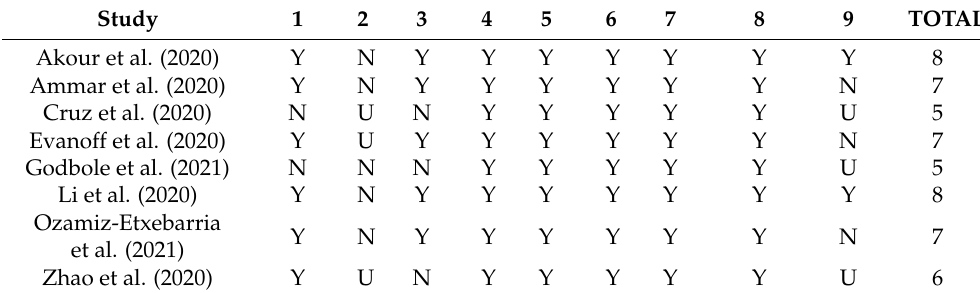
Table 3. Quality